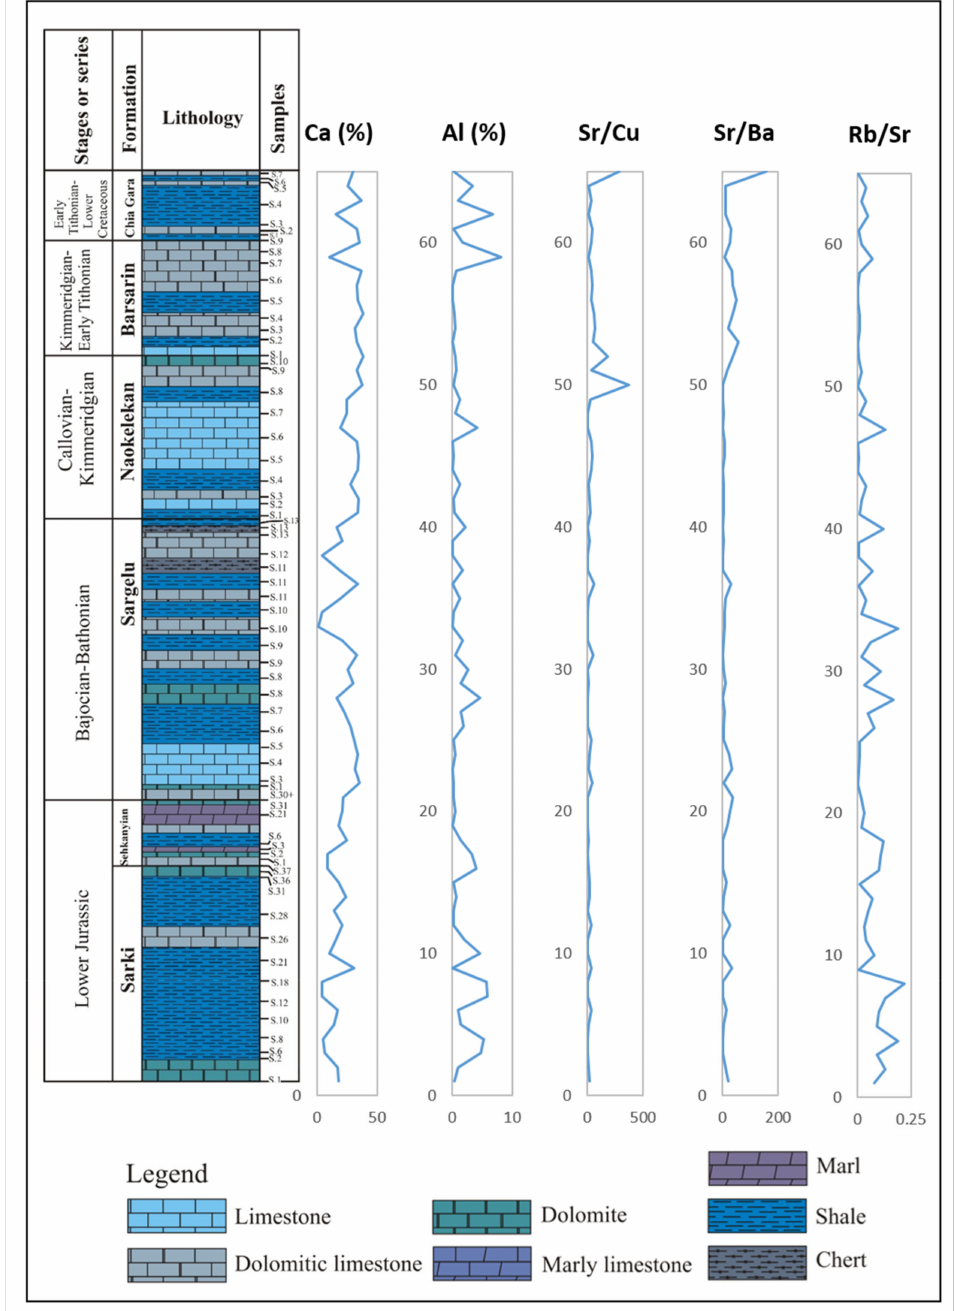
Figure 6. Chart showing geochemical proxies for paleoclimate conditions along the measured log of the Warte section, northeastern Iraqi